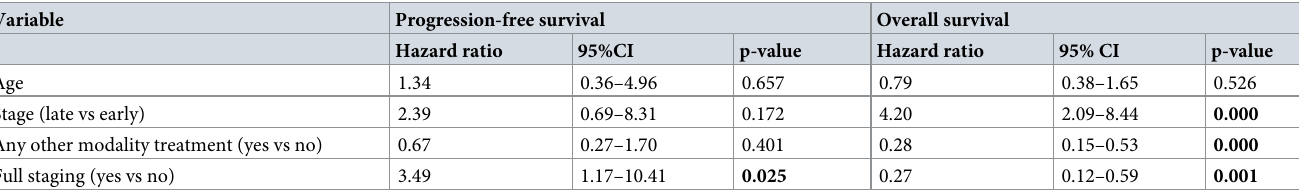
Table 7. Multivariate analysis of factors influencing PFS and OS (significant p-values in bold) (n =